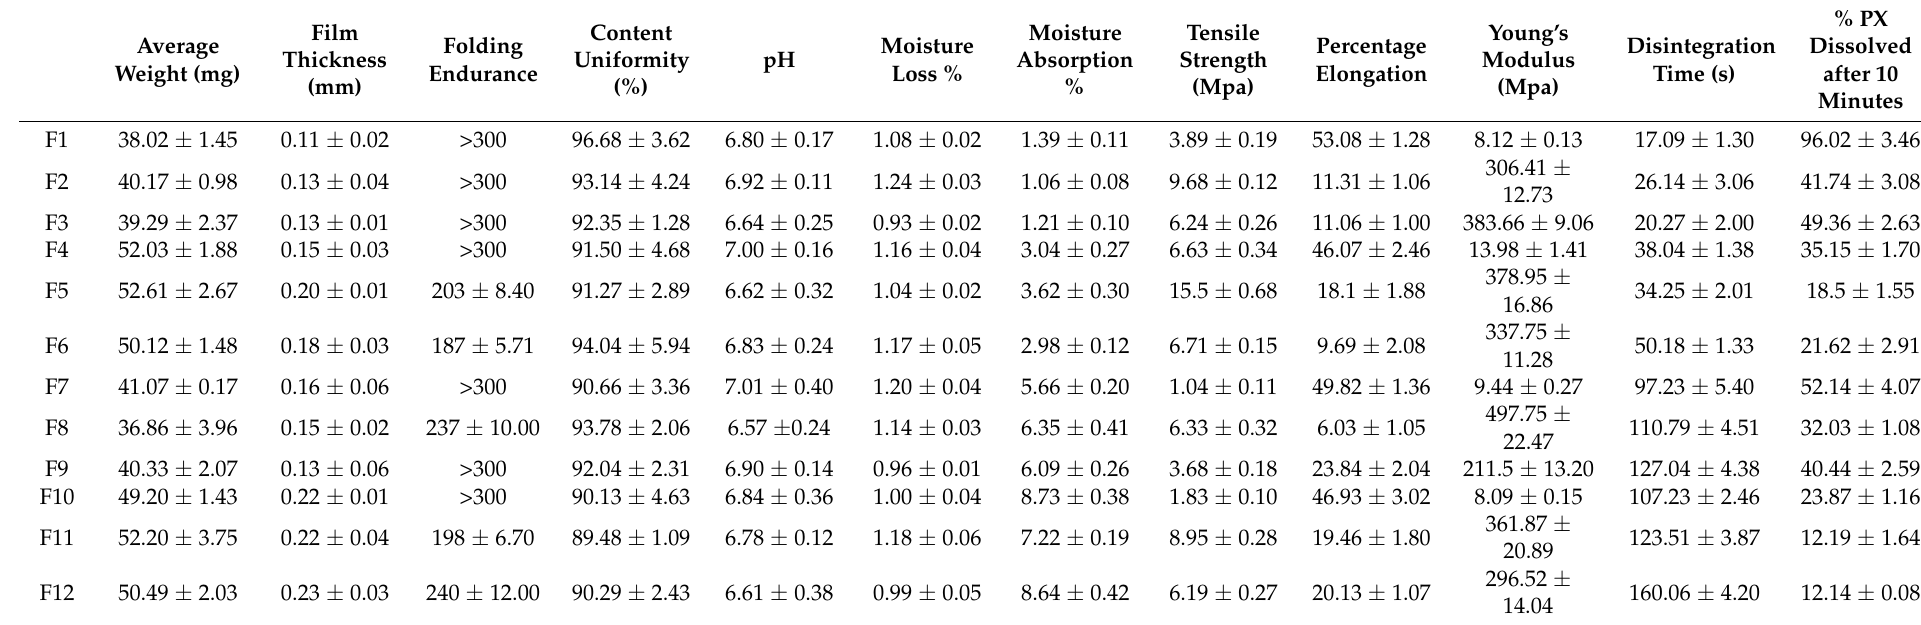
Table 3. Pharmaceutical evaluation and measured responses of the prepared oral fast-dissolving films loaded with PX